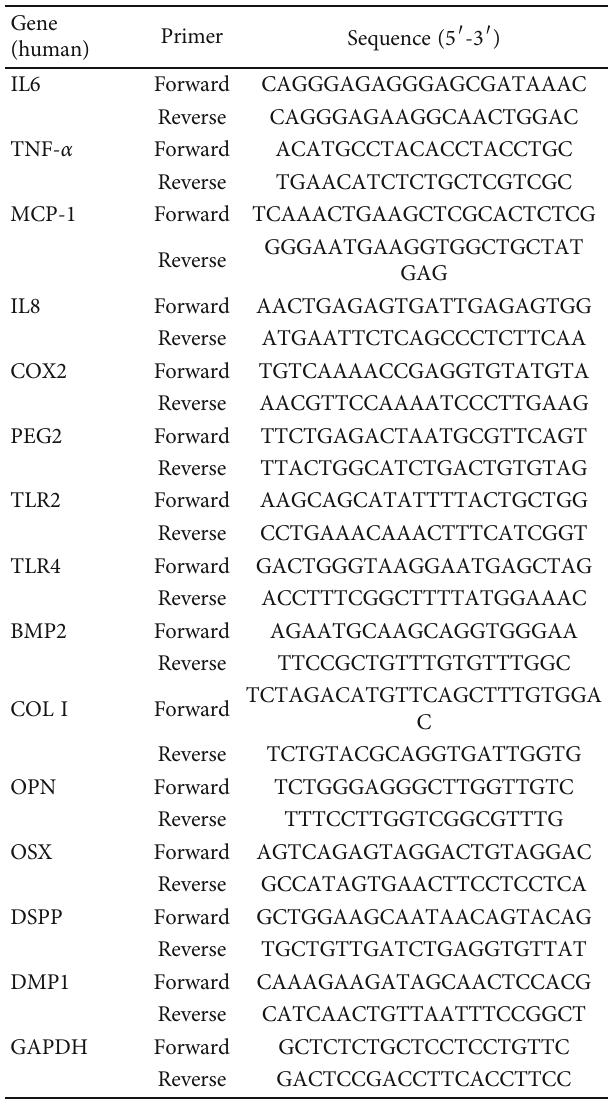
Table 1: qPCR genes and primer